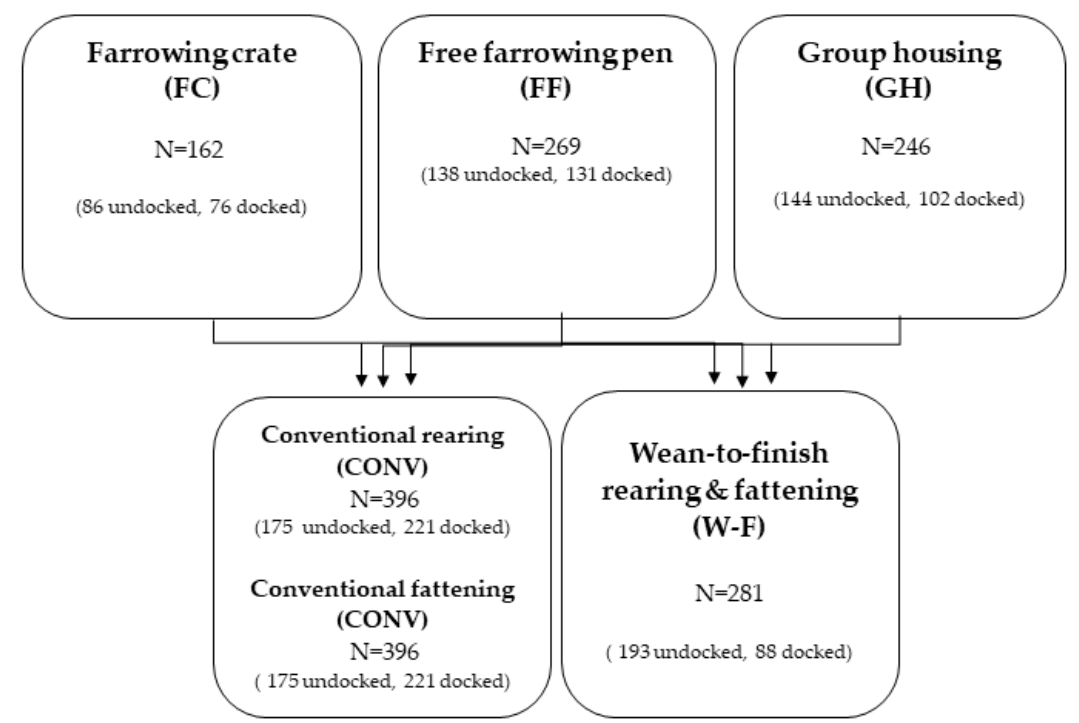
Figure 1. Schematic overview of the 3 × 2 × 2 factorial experimental design.